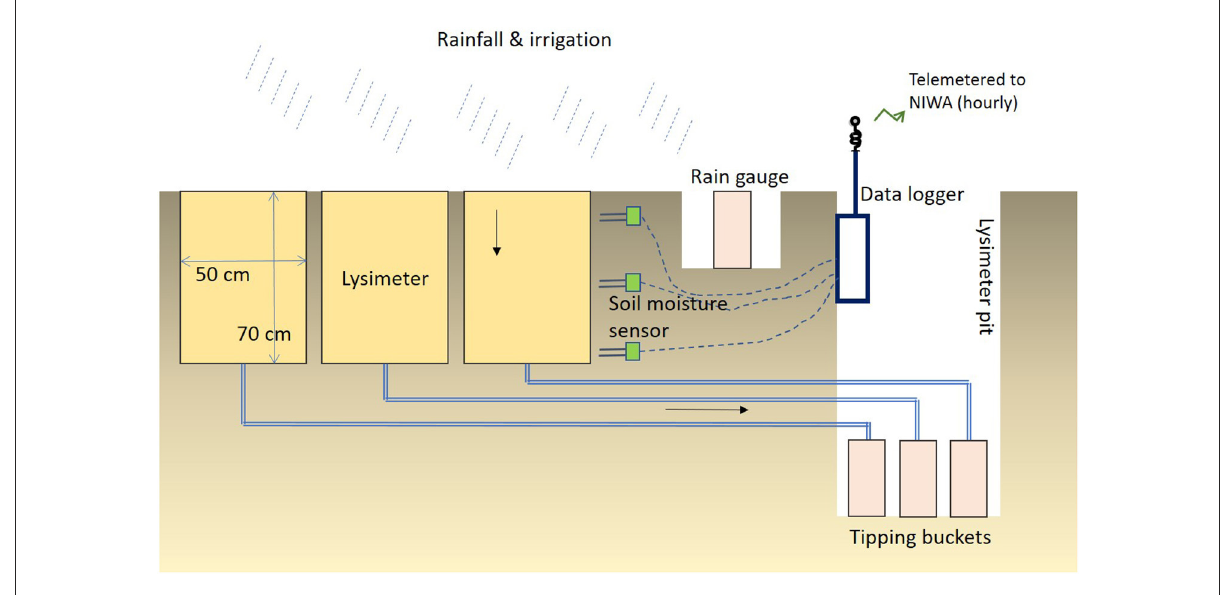
FIGURE3 Schematic of lysimeter instrument (Source: Duncan et al.,